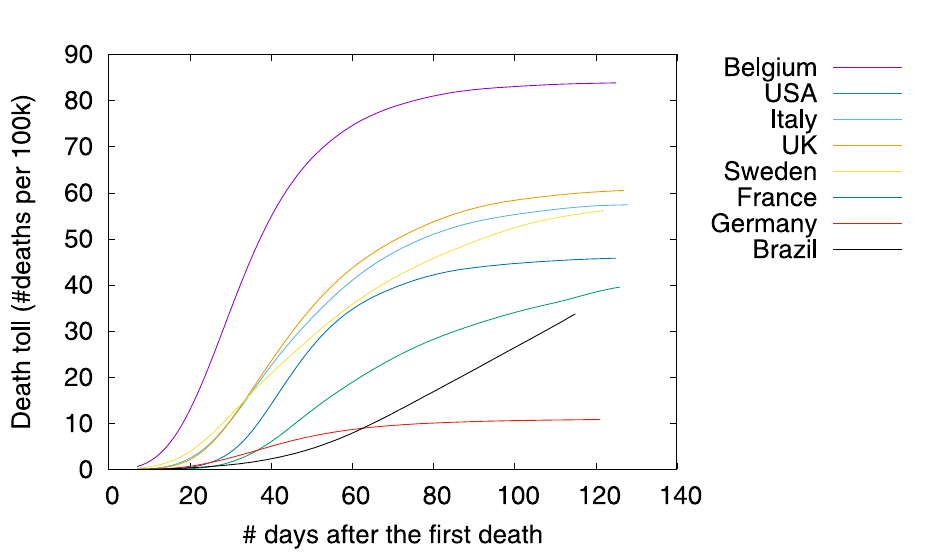
Fig 1. COVID-19 death toll, as of June 5th